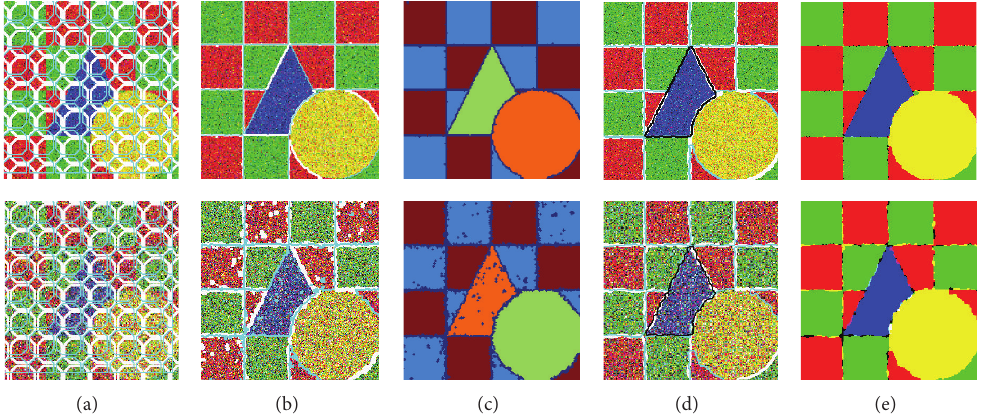
Figure 9: Results for a synthetic image added with Gaussian noise with deviations 0.1, 0.5, respectively. (a) Original noisy images and initial contours; (b) the final contours of the FMLSM model; (c) the segmentation results of the FMLSM model labeled with different colors; (d) the final contours of the proposed model; (e) segmentation results of the proposed model labeled with different colors.